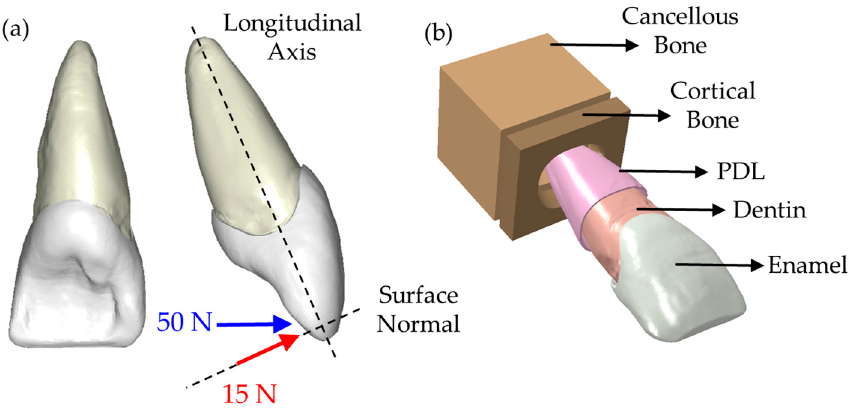
Figure 3. ( a ) Applied forces and ( b ) CAD model of the sound tooth.